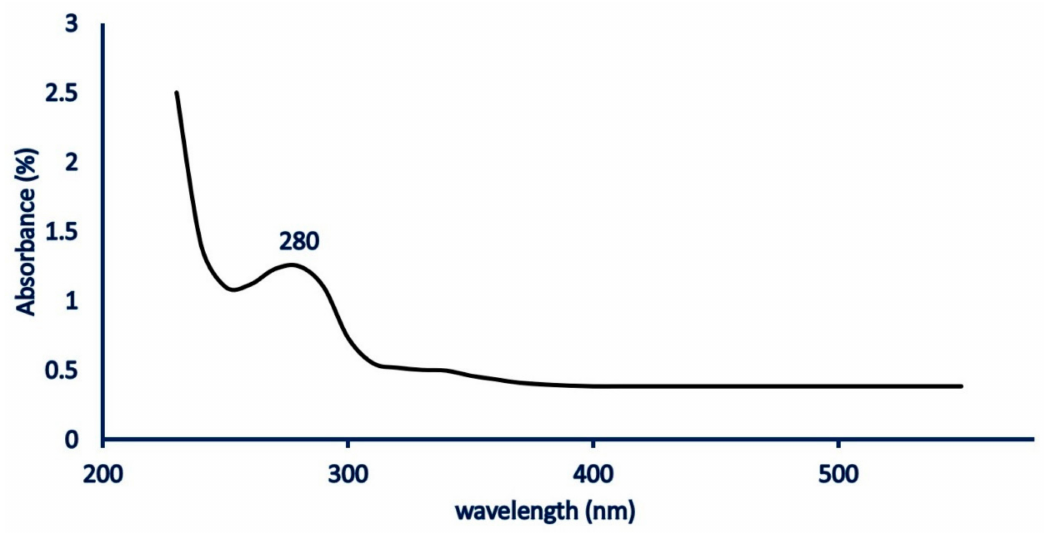
Figure 2. UV-Vis spectroscopy of myco-synthesized MgO-NPs showed maximum SPR at 280